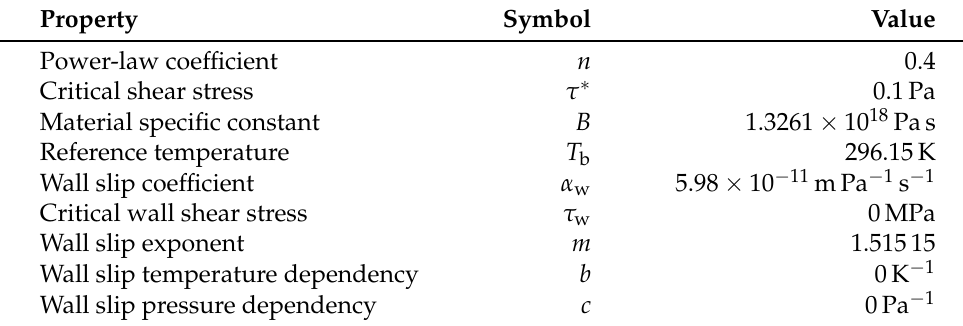
Table A5. M OLDFLOW simulation parameters.